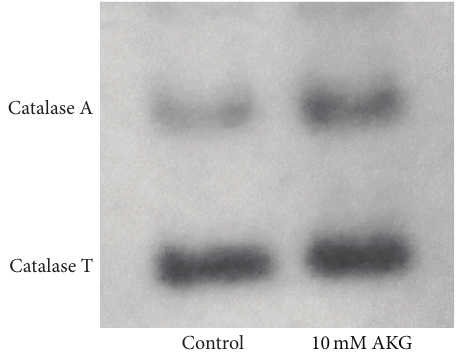
Figure 4: Native PAGE electrophoresis of catalase isoforms in S. cerevisiae YPH250 cells grown in the absence or presence of 10mM AKG. An amount of total protein applied to each well was 10 𝜇